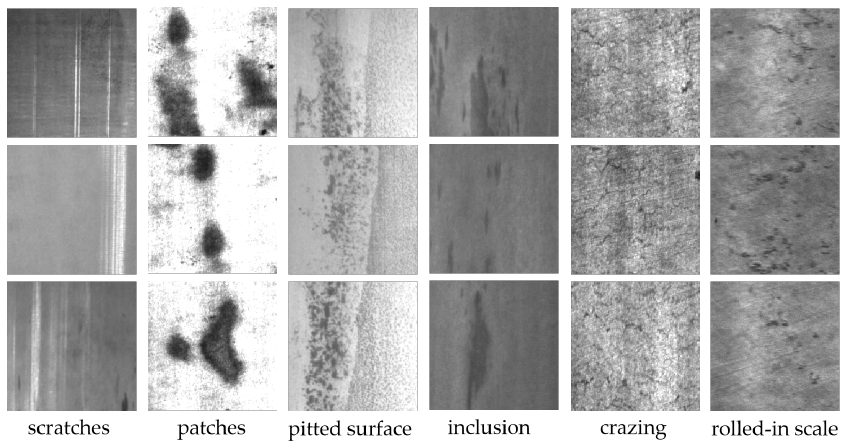
Figure 3. Samples of six types of the defects on the surfaces from the